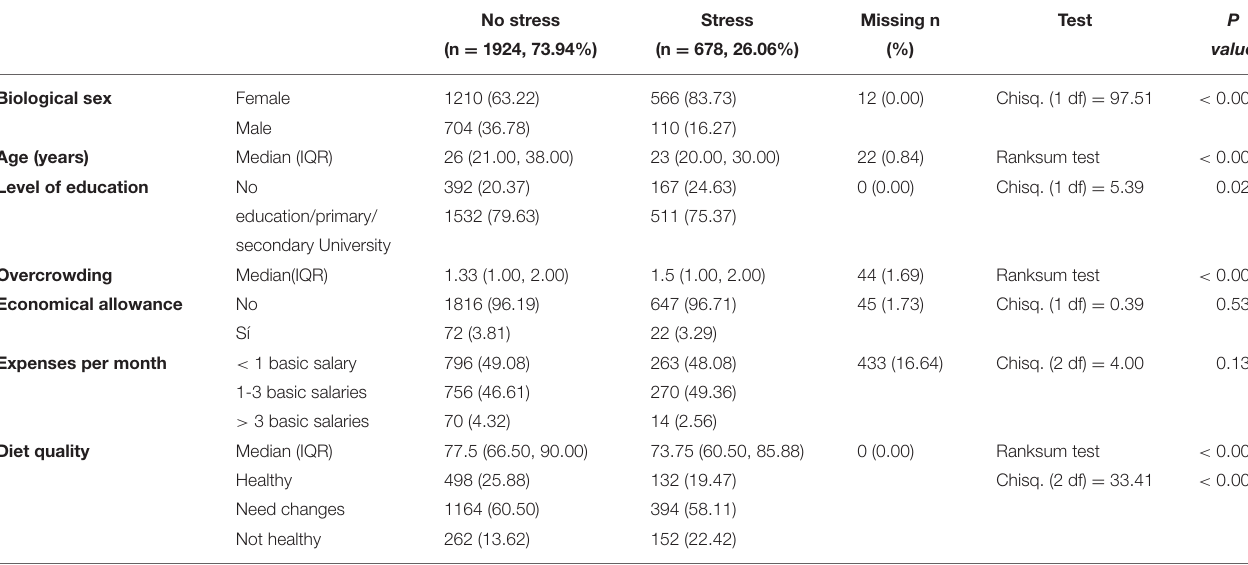
TABLE 1 | General characteristics of the sample by level of